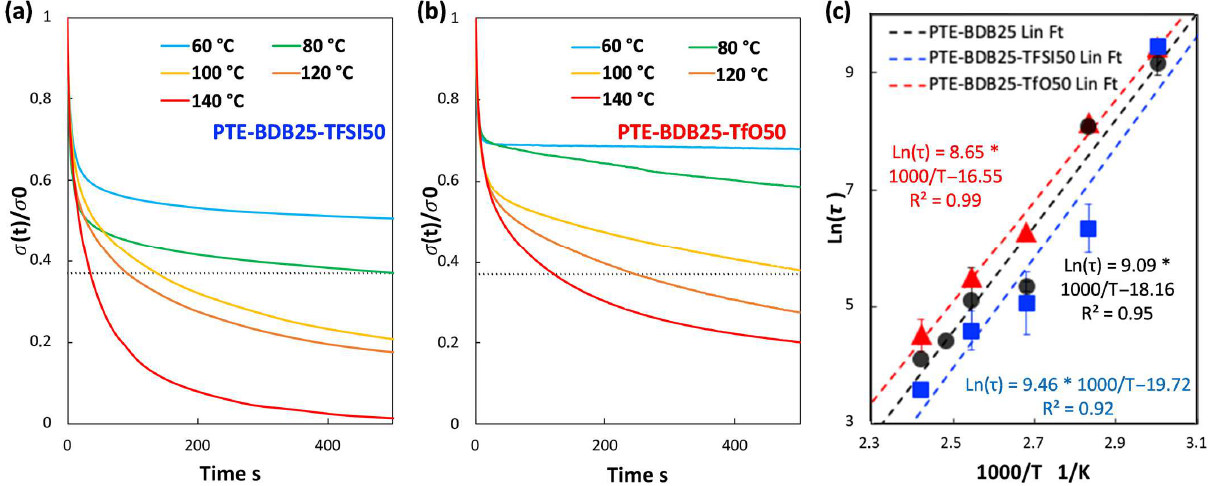
Figure 6. ( a ) Stress relaxation tests of PTE-BDB25-TFSI50 sample at various temperatures; ( b ) The stress relaxation tests of the PTE-BDB25-TfO50 sample at various temperatures; ( c ) Arrhenius linear plot extracted from relaxation times of the ( (cid:4) ) PTE-BDB25-TFSI50, ( (cid:78) ) PTE-BDB25-TFSI50, and ( • ) PTE-BDB25 samples at different temperatures.